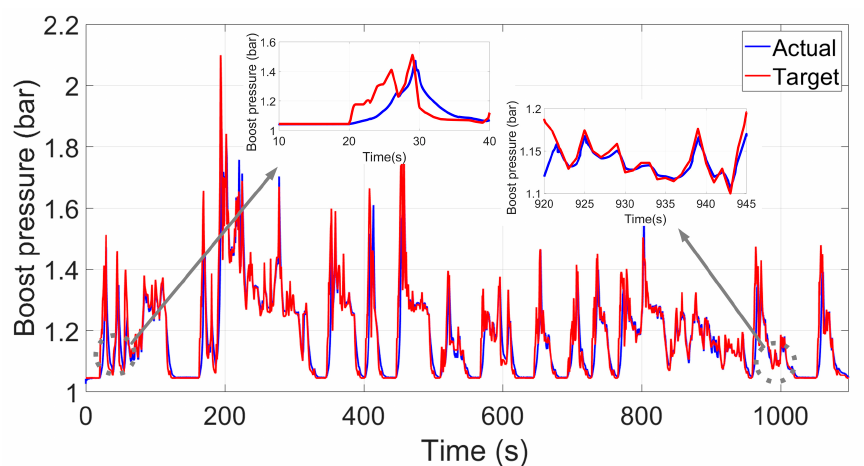
Figure 13. Track of all rewards per episode.